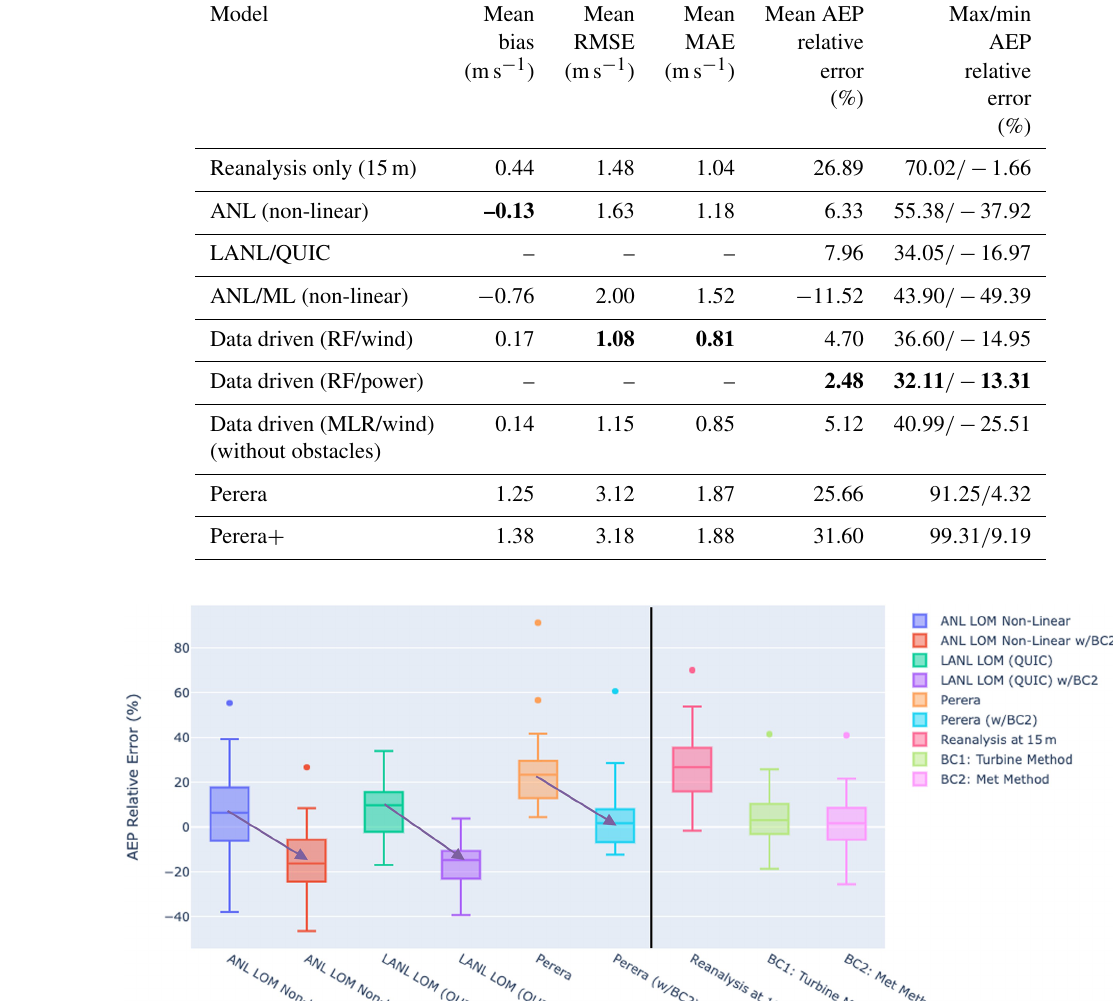
Table 5. Results comparison for validation sites (averages). Bold values show the best performing result for each metric.